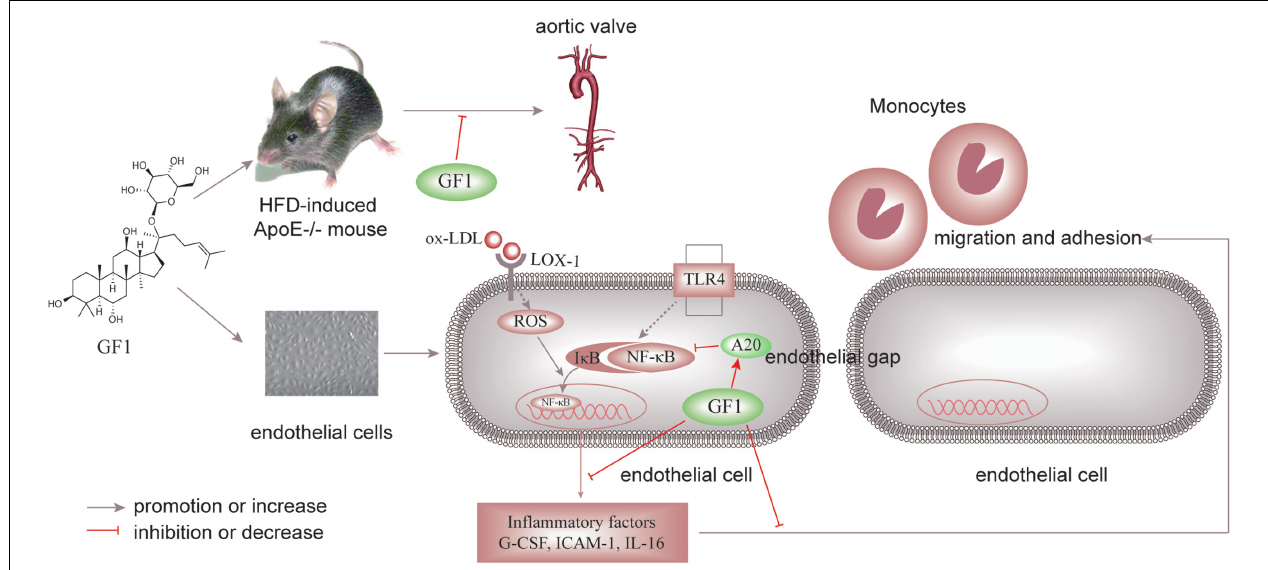
FIGURE 8 | Schematic of GF1 mechanism of preventing ox-LDL-induced inflammatory injuries through activating A20-mediated NF- κ B signal